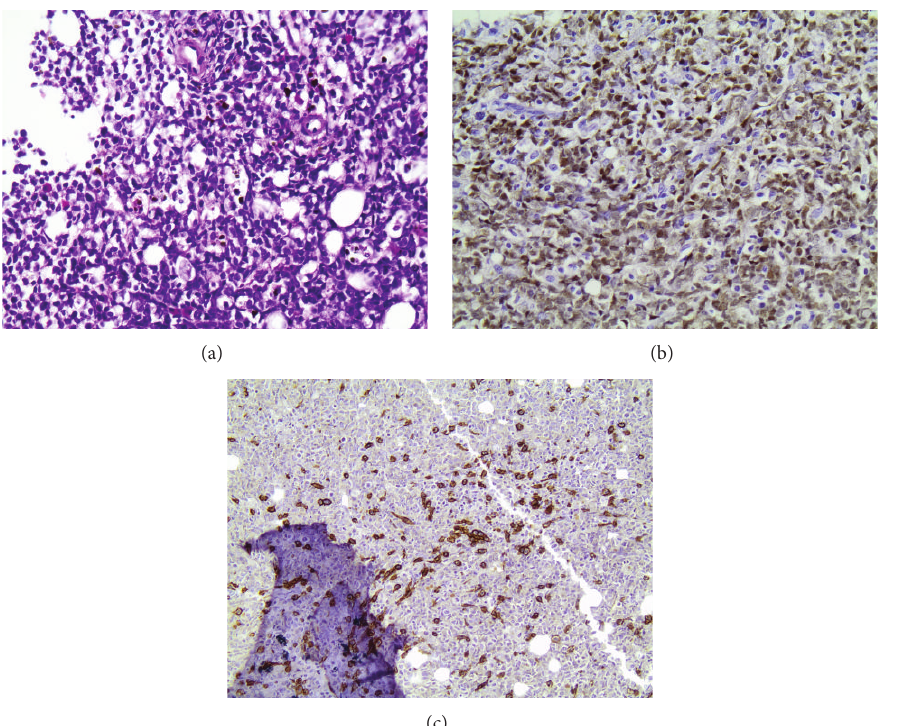
Figure 3: Final bone marrow trephine biopsy in which there is extensive infiltration by medium sized lymphoblasts (a), which were immunohistochemically positive for TDT (b). Concurrent mast cell infiltration is also observed (c-KIT immunohistochemical analysis